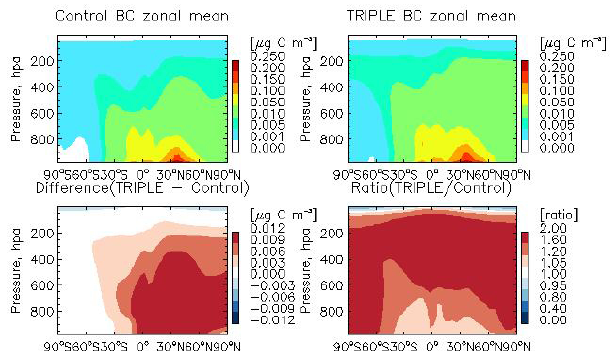
Fig. 7c. Same as Fig. 7a but for zonal